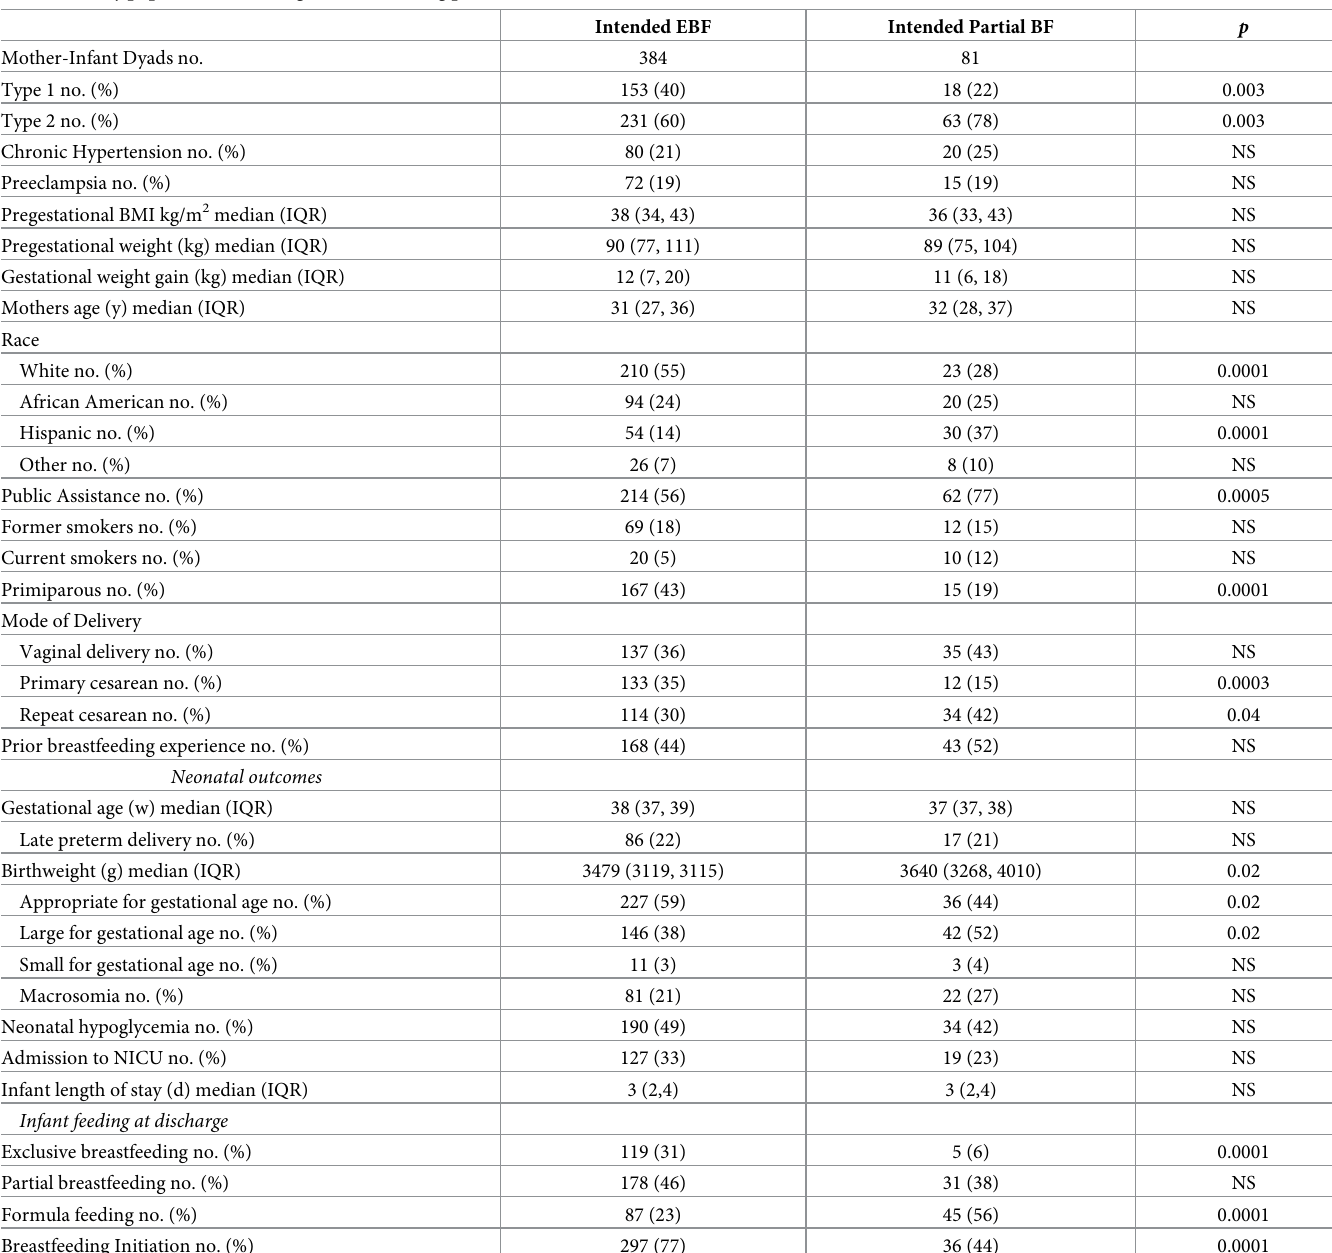
Table 2. Study population according to infant feeding